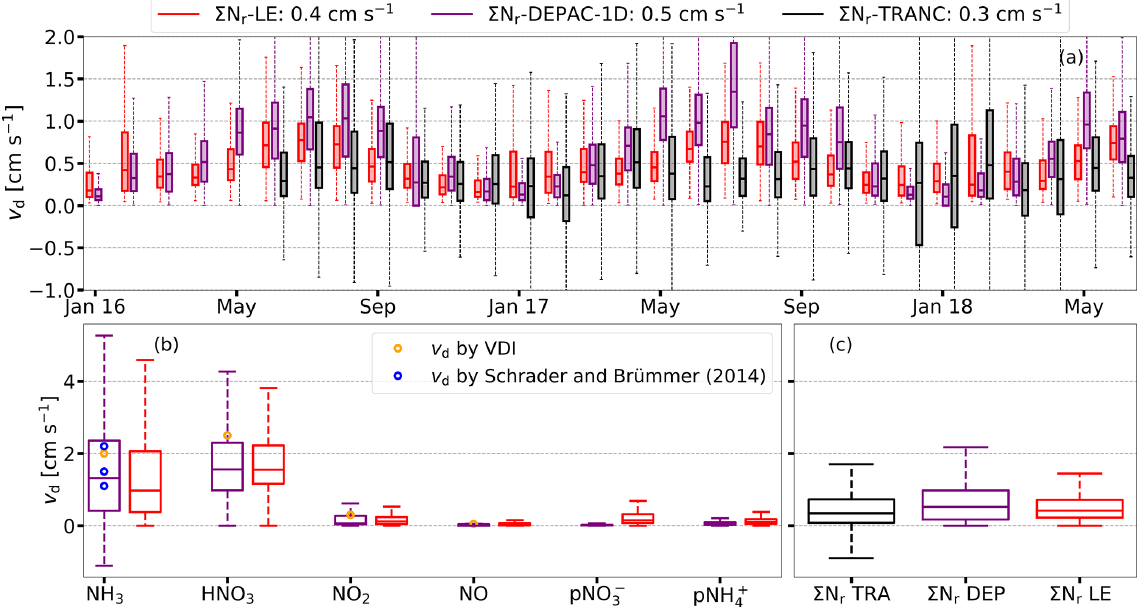
Figure 3. Monthly v d of (cid:54) N r determined from TRANC (black) measurements, DEPAC-1D (purple), and LOTOS-EUROS (red), with the corrected land-use weighting in cms − 1 represented as box-and-whisker plots in the upper panel (a) . In the corresponding legend, the median v d related to the entire campaign are given. In the lower panels (b, c) , box-and-whisker plots of v d for each N r compound and (cid:54) N r based on the entire campaign (TRA = TRANC, DEP = DEPAC-1D, LE = LOTOS-EUROS) are shown. Blue circles refer to NH 3 deposition velocities reported by Schrader and Brümmer (2014) for deciduous forests, mixed forests, and spruce forests (from low to high); orange circles show deposition velocities proposed by VDI